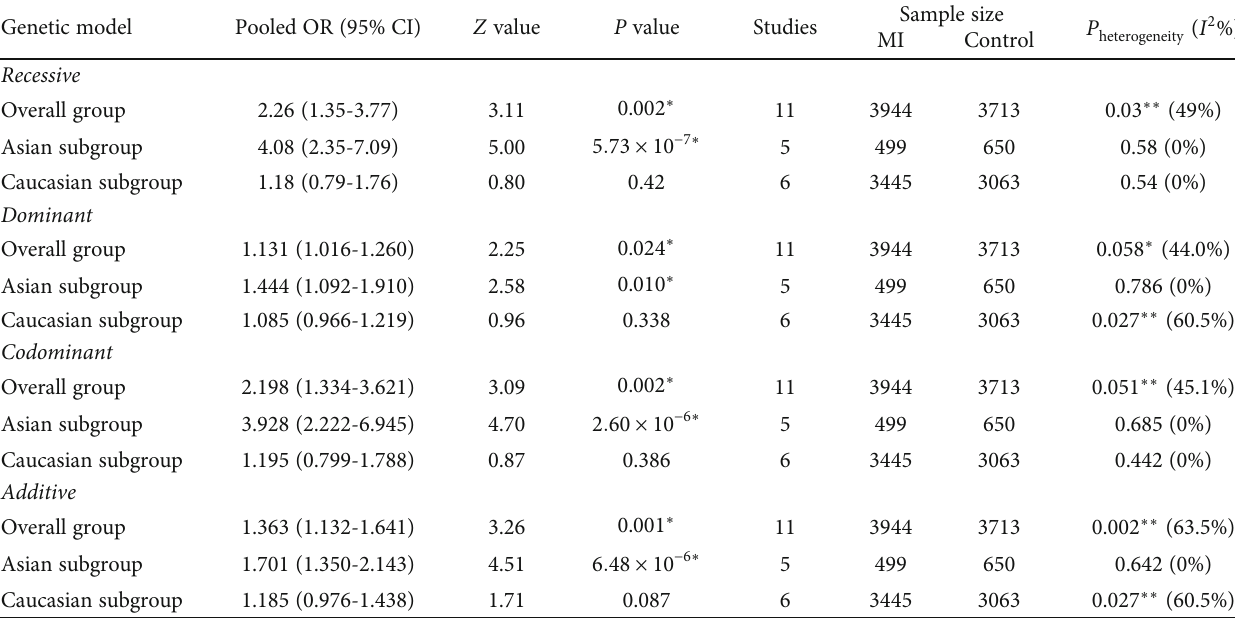
Table 2: Summary results of meta-analysis on association between AGT p.Thr174Met polymorphism and myocardial infarction.